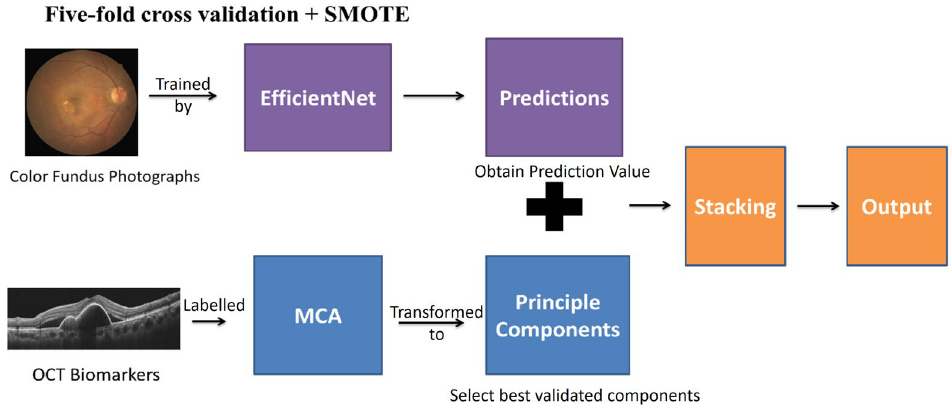
Figure 1. Framework of model training. The flowchart revealed the framework of model training by combining CFPs and OCT biomarkers. First, the CFPs were trained by EfficientNet model to obtain prediction value. Second, the OCT biomarkers were labelled by retinal specialist and then were dimension-reduced and transformed to principal components by multiple correspondence analysis (MCA). Third, merging the two steps to achieve the final results by stacking technique. Abbreviation: MCA multiple correspondence analysis.